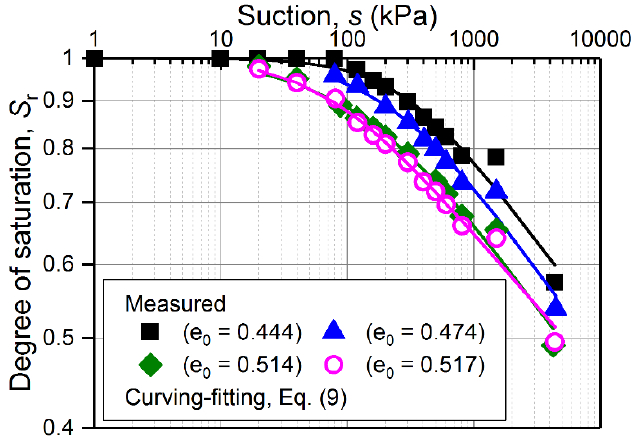
Figure 3. Main drying curves in the log s –log S r plane (data from Vanapalli et al. [37]).